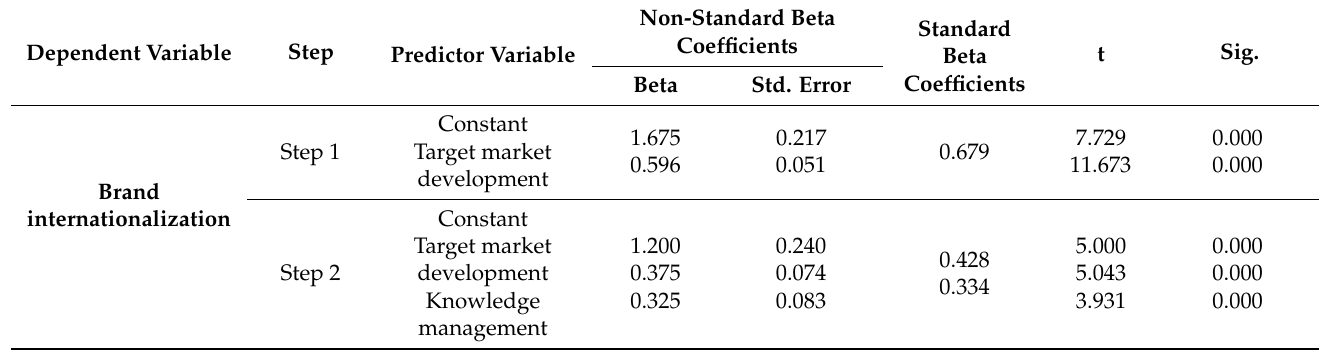
Table 10. The beta coefficient in predicting brand internationalization by applying business intelli- gence dimensions.